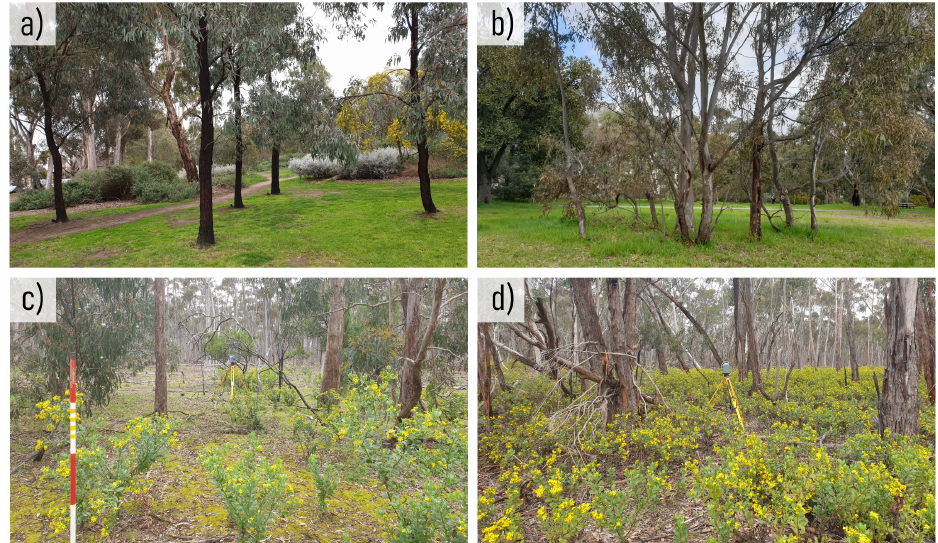
Figure 1. Examples of characteristic vegetation within each site environment. ( a ) Less dense stems at S1, ( b ) more dense stems at S1, ( c ) less dense surrounding understory vegetation at S2, and ( d ) more dense surrounding understory vegetation at